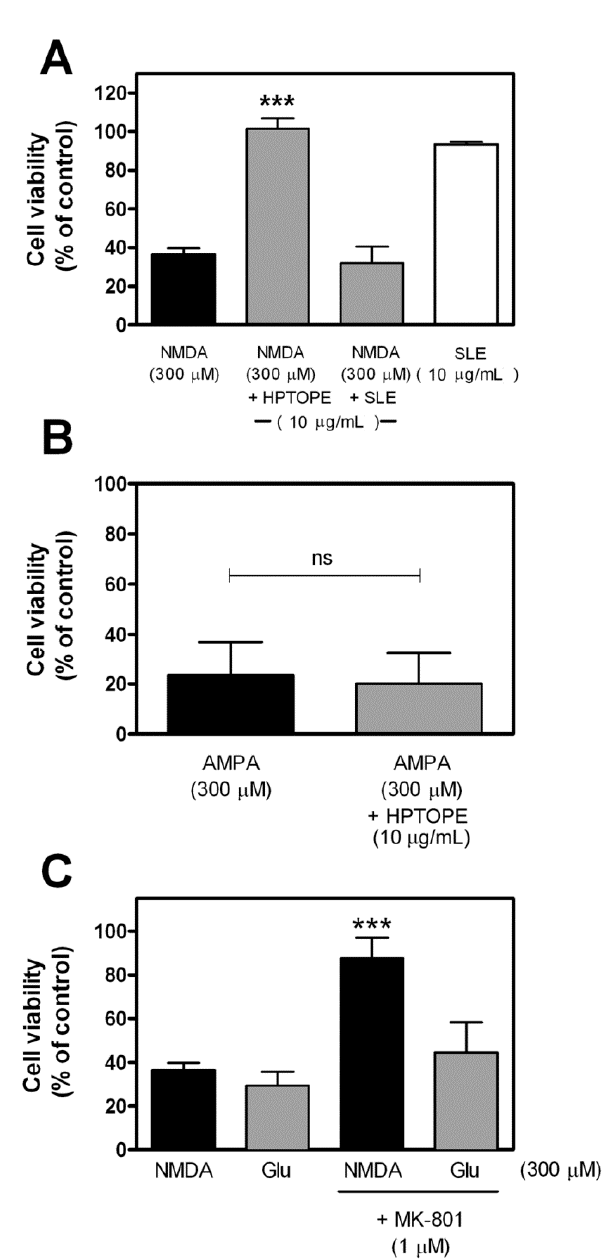
Figure 3. Cell viability of cortical neurons following glutamate receptor stimulation in the presence of either HPTOPE or a solid–liquid extract (SLE). After 14 DIV, neurons were treated for 24 h at 37 ◦ C with the indicated stimuli. Cell viability was evaluated by NRU assay. ( A ) Data are means ± SEM from fourteen ( N -methyl- d -aspartate (NMDA) and NMDA + HPTOPE) or three (NMDA + SLE and SLE) independent experiments in triplicate. *** p < 0.001, according to ANOVA, followed by Tukey’s post-hoc test. ( B ) Values represent means ± SEM from two independent experiments in duplicate. ns, not statistically significant, according to t -test. AMPA: α -amino-3-hydroxy-5-methyl-4-isoxazolepropionic acid. ( C ) Data are means ± SEM from fourteen (NMDA), nine (Glu), six (Glu + dizocilpine (MK–801)), or five (NMDA + MK-801) independent experiments in triplicate. *** p < 0.001 vs. NMDA, according to ANOVA, followed by Tukey’s post-hoc test.